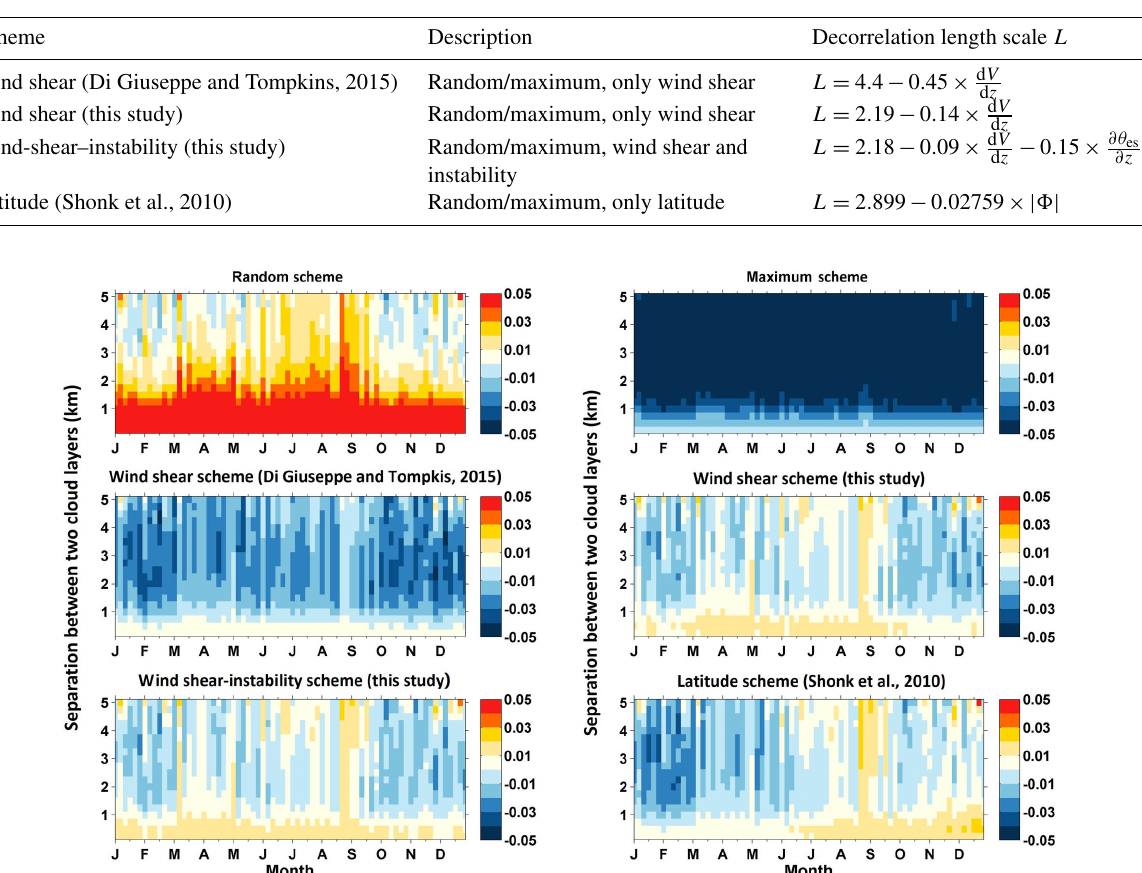
Figure 6. The monthly differences in total cloud cover (unitless) between calculation and observation for different schemes (see Table 1) and their dependence on the layer